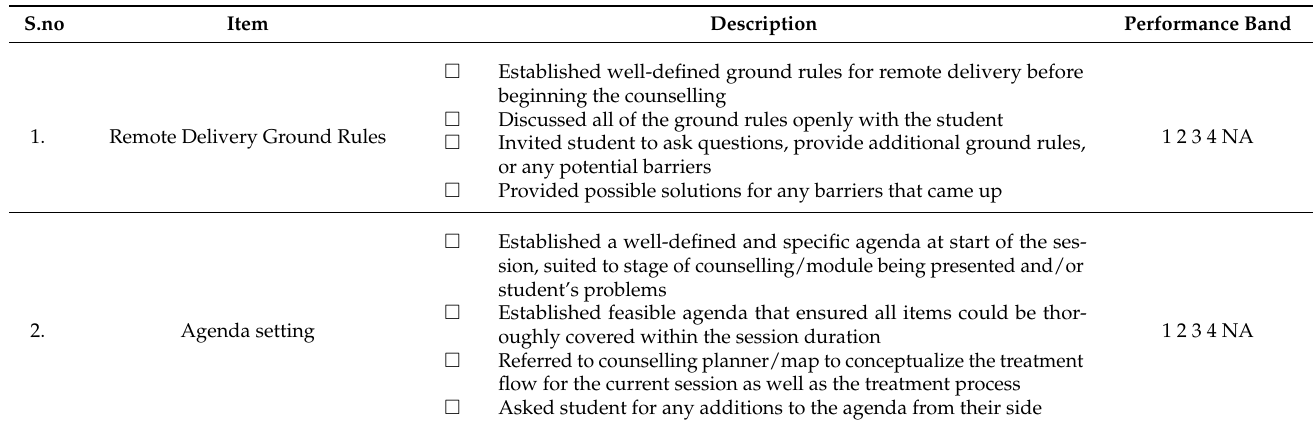
Table A1. PRIDE Therapy Quality Rating Scale